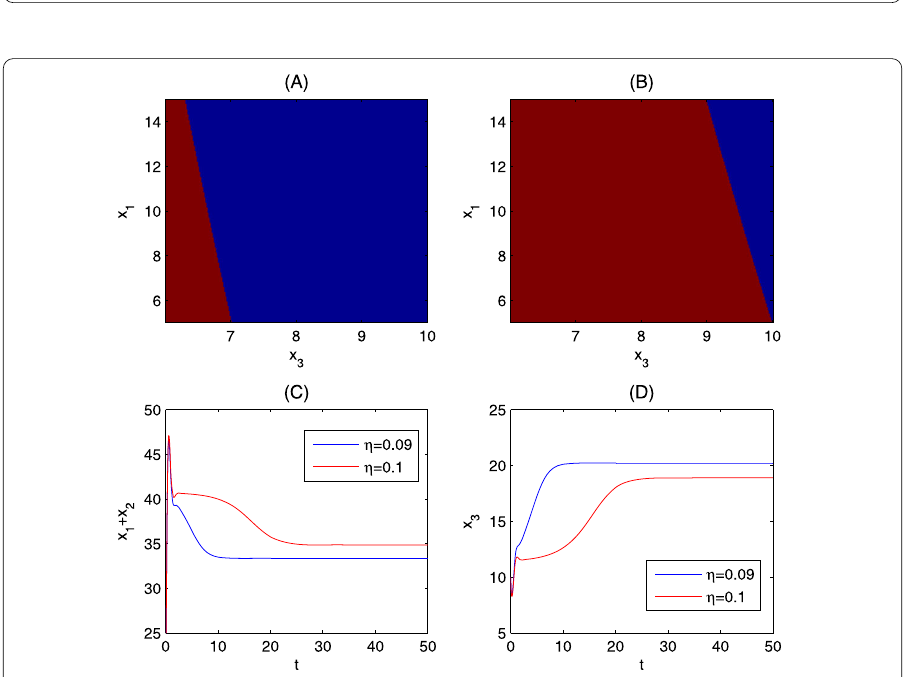
Figure 5 The basin of attraction domain of system (1) when η = 0.09 in ( A ) and η = 0.1 in ( B ), and we fix the initial value of x 2 as 5. ( C ) and ( D ) Solutions of system (1) with the initial condition being (6,5,10). Here, b = 90 and the other parameter values are the same as those in Fig. 3